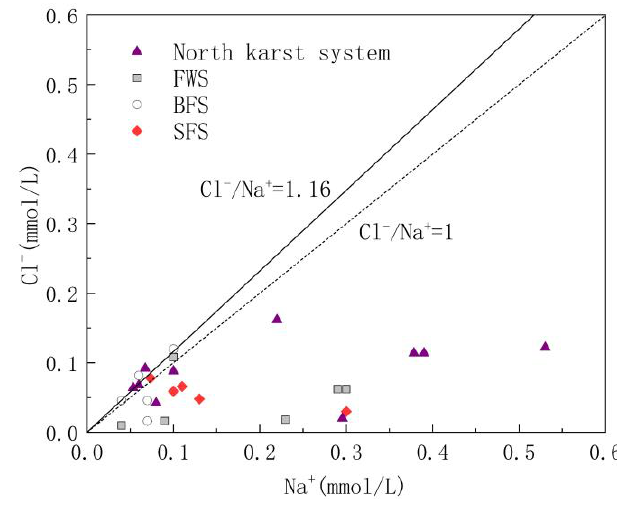
Figure 4. Relationship diagram of Cl − /Na + in underground water samples.